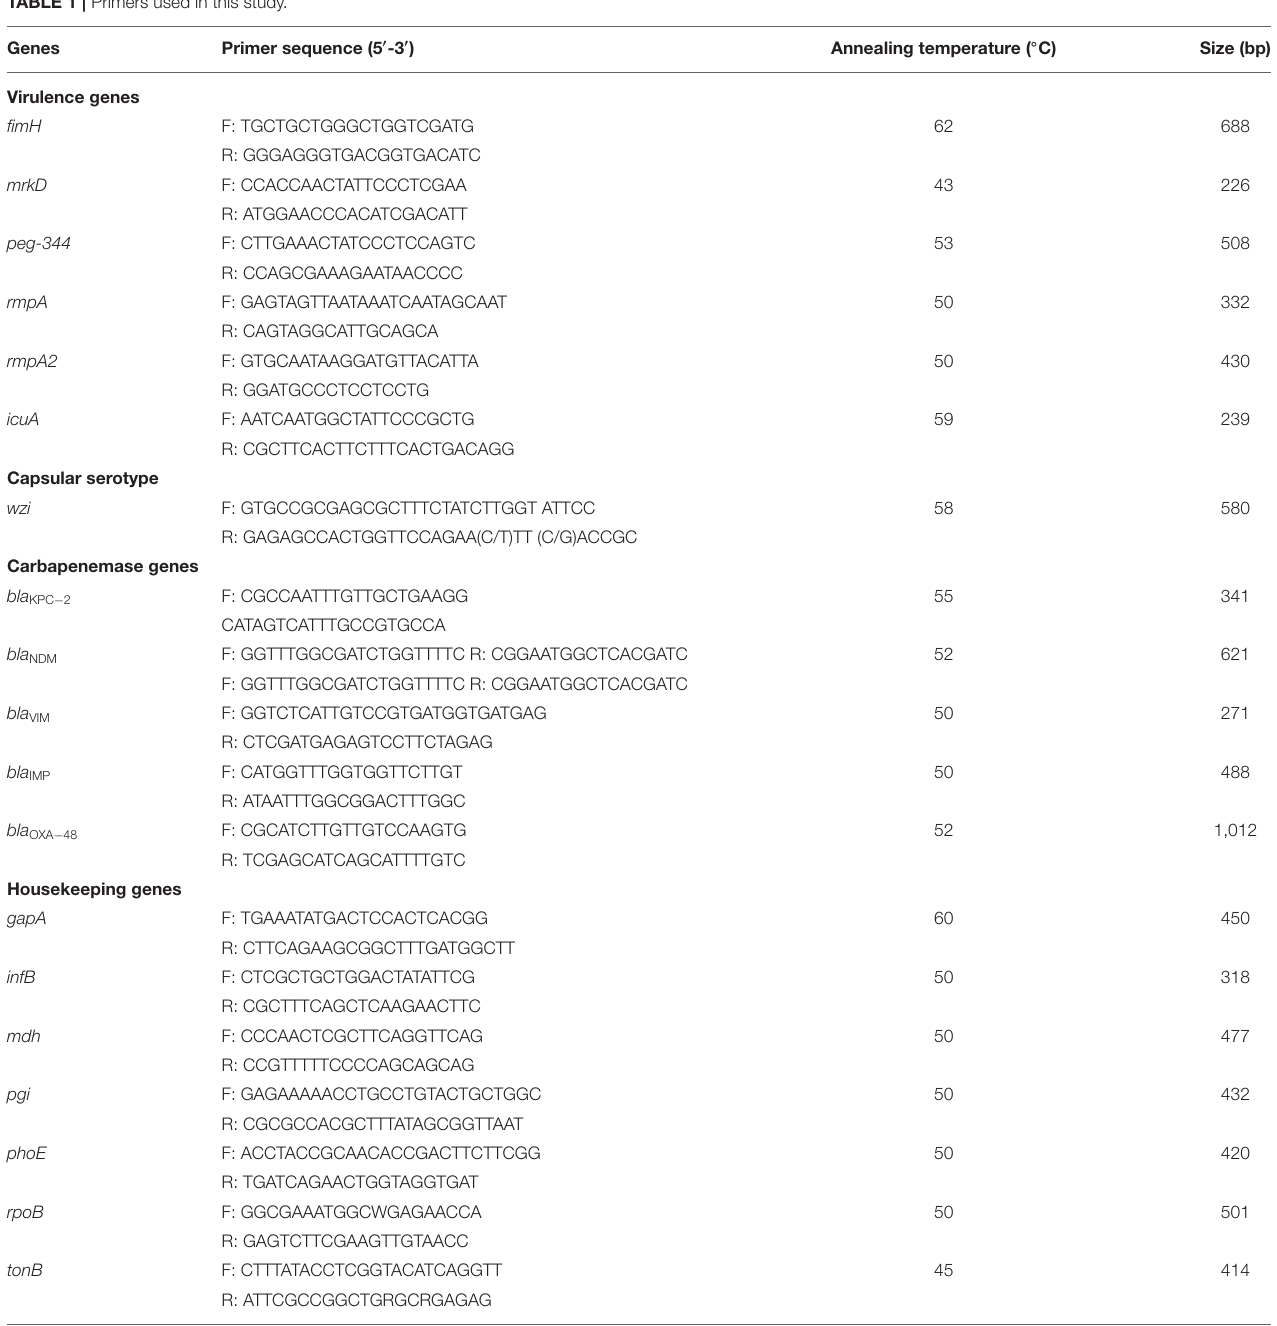
TABLE 1 | Primers used in this study. Genes Primer sequence (5 ′ -3 ′